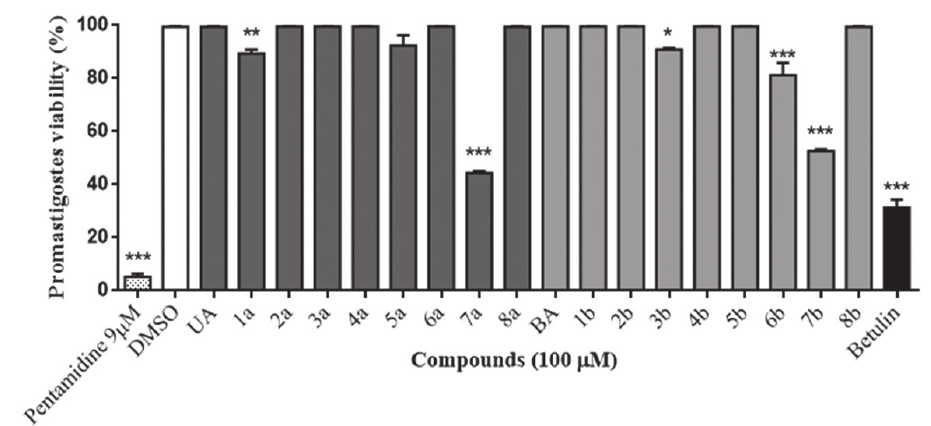
FIGURE 4 – Anti- L. amazonensis activity of UA and BA derivatives. Each bar represents the mean ± standard deviation of at least three independent experiments. Statistically significant differences (p ≤ 0.05) between treated and non-treated groups are indicated by